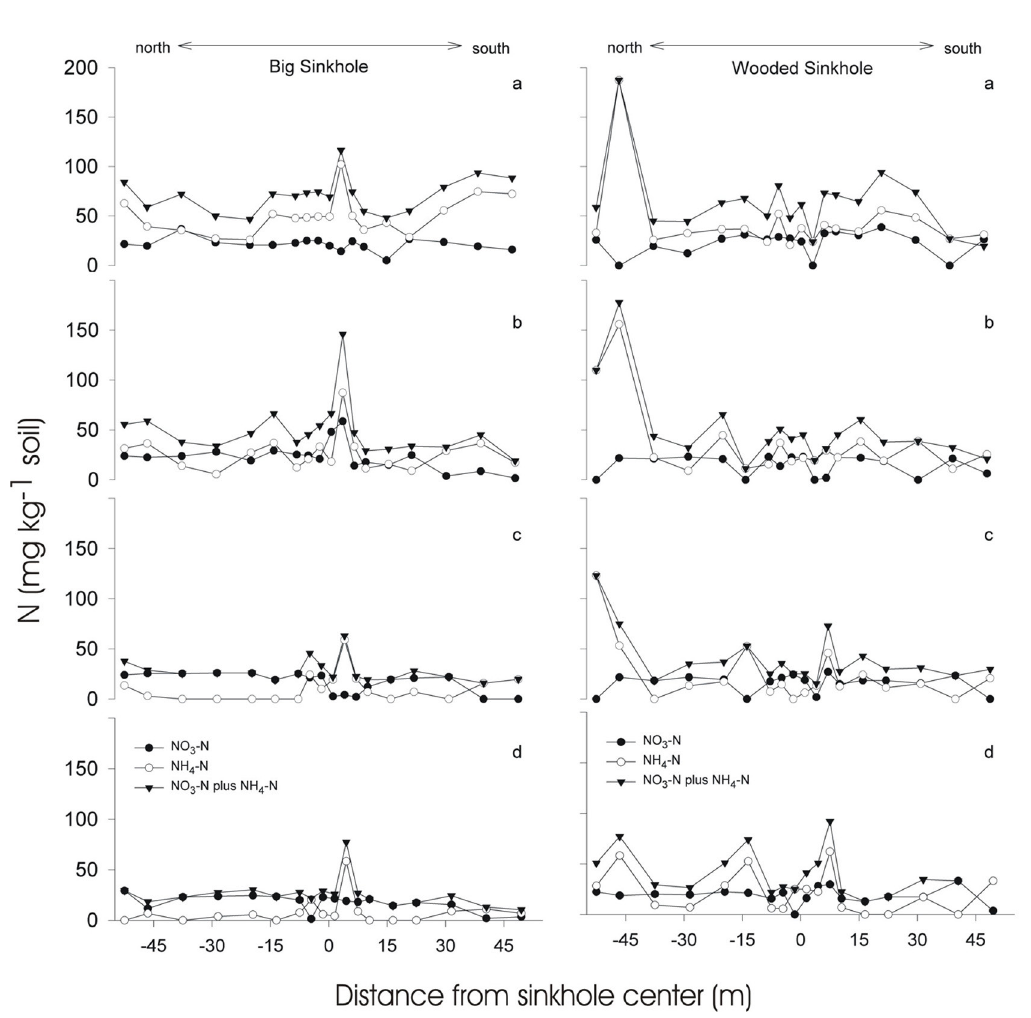
FIGURE 2. Mean water extractable NO Sinkhole (ungrazed since 1989) at soil depths (a) 0 to 2.5 cm, (b) 2.5 to 5 cm, (c) 5 to 10 cm, and (d) 10 to 20